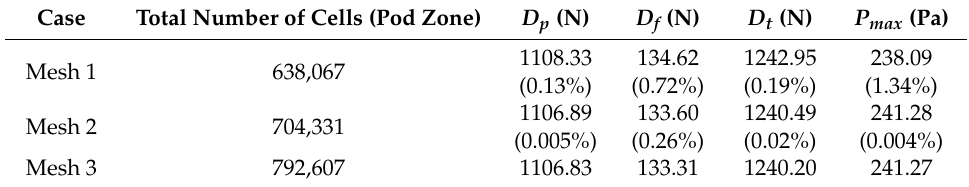
Table 1. Grid independent test: Only the pod zone is demonstrated. Drag force and maximum pressure are used to estimate the grid. D p —pressure drag, D f —friction drag, D t —total drag, and P max —maximum pressure. Mesh 2 is applied in all simulations. Total number of elements